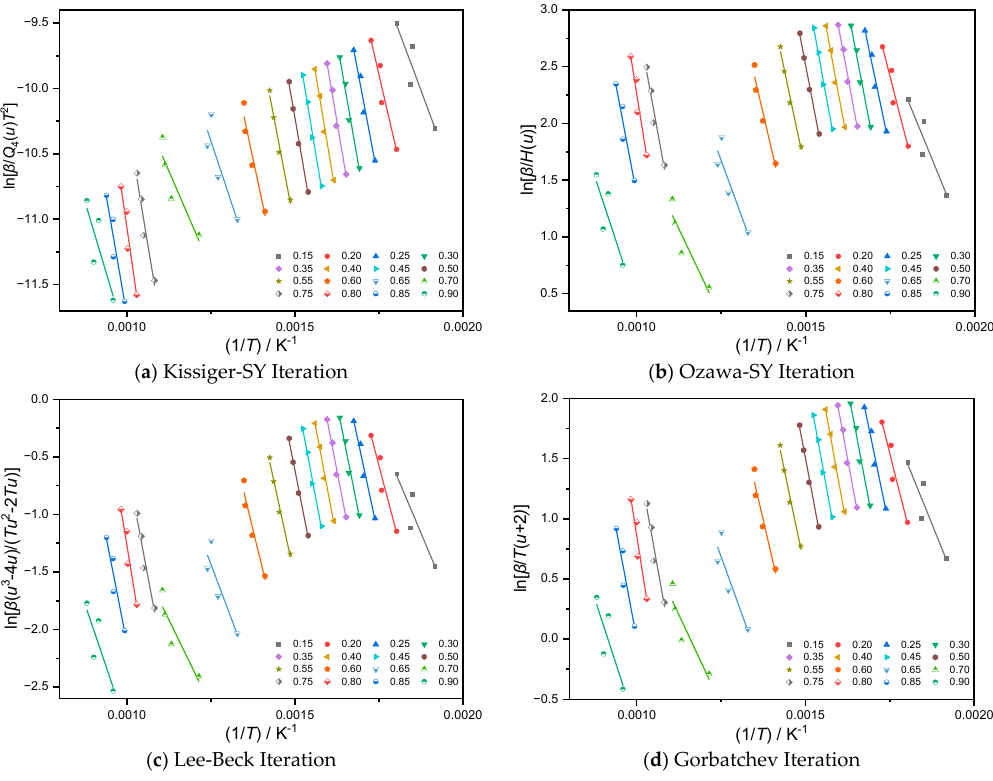
Figure 2. Linear regression fitting diagram of the equal conversion method of Al-lignin, based on four temperature